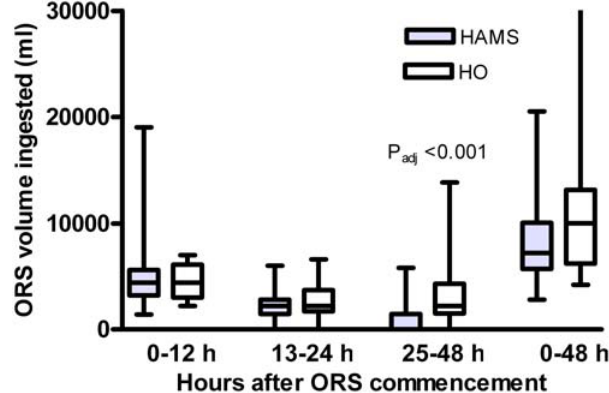
Figure 4. ORS intake in mL during the time periods 0–12, 13– 24, and 25–48 hours and total ORS intake (last two box plots). The box and whiskers plots show median and IQR (box) and lowest and highest value (whiskers). Two-tailed adjusted P values (Mann-Whitney) show the significance of differences between HAMS and HO ORS for that particular time period.